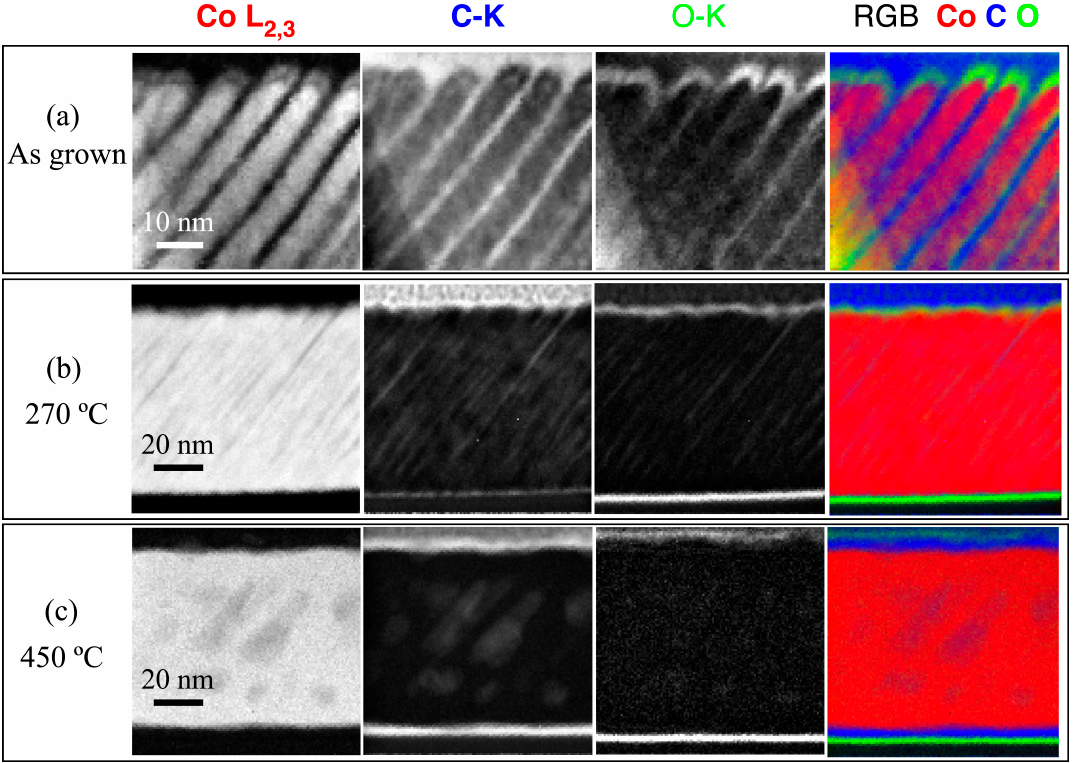
Figure 8. STEM-EELS chemical maps of an obliquely deposited Co film in the as-deposited state ( a ), annealed at 270 °C ( b ) and annealed at 450 °C ( c ).